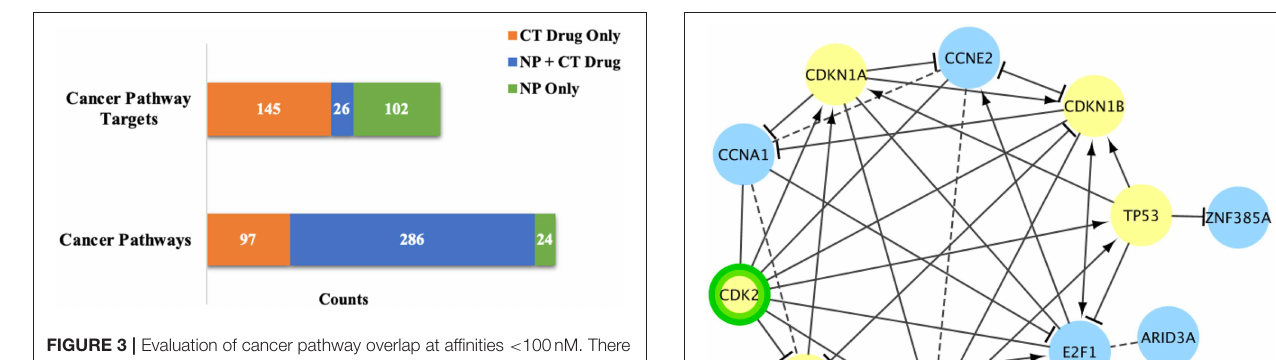
FIGURE 3 | Evaluation of cancer pathway overlap at affinities < 100nM. There is a high level of pathway overlap between those targeted by NPs and CT drugs, but little overlap at the individual target level.